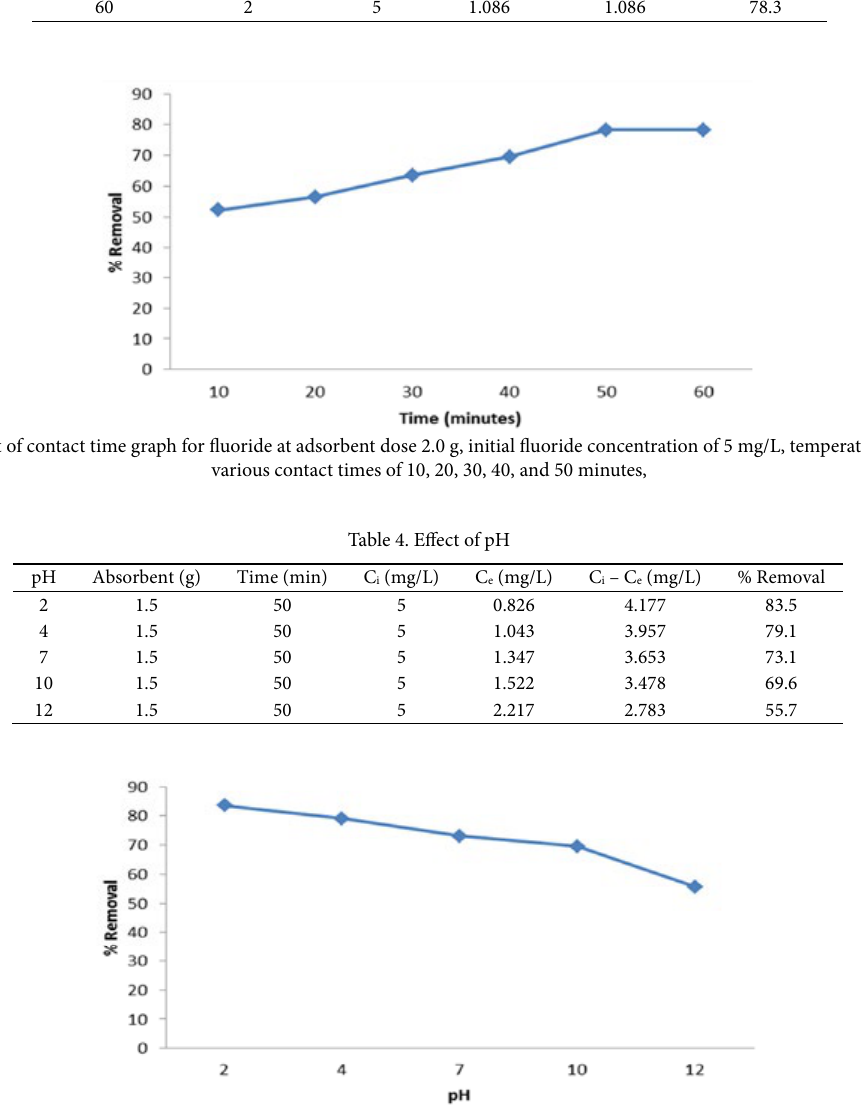
Fig. 4. Effect of contact time graph for fluoride at adsorbent dose 2.0 g, initial fluoride concentration of 5 mg/L, temperature of 25 o C, contact time of 50 minutes, and various pHs of 2, 4, 7, 10 and 12